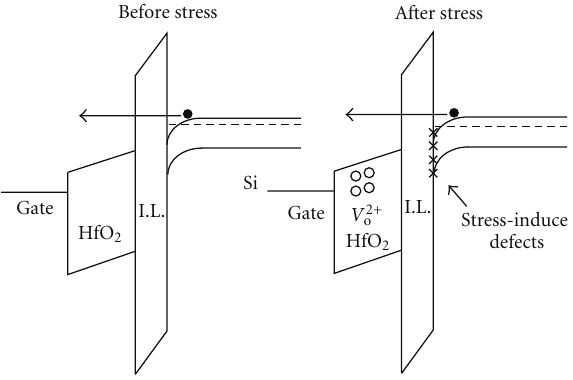
Figure 8: Band diagram of I G - V G curve in accumulation